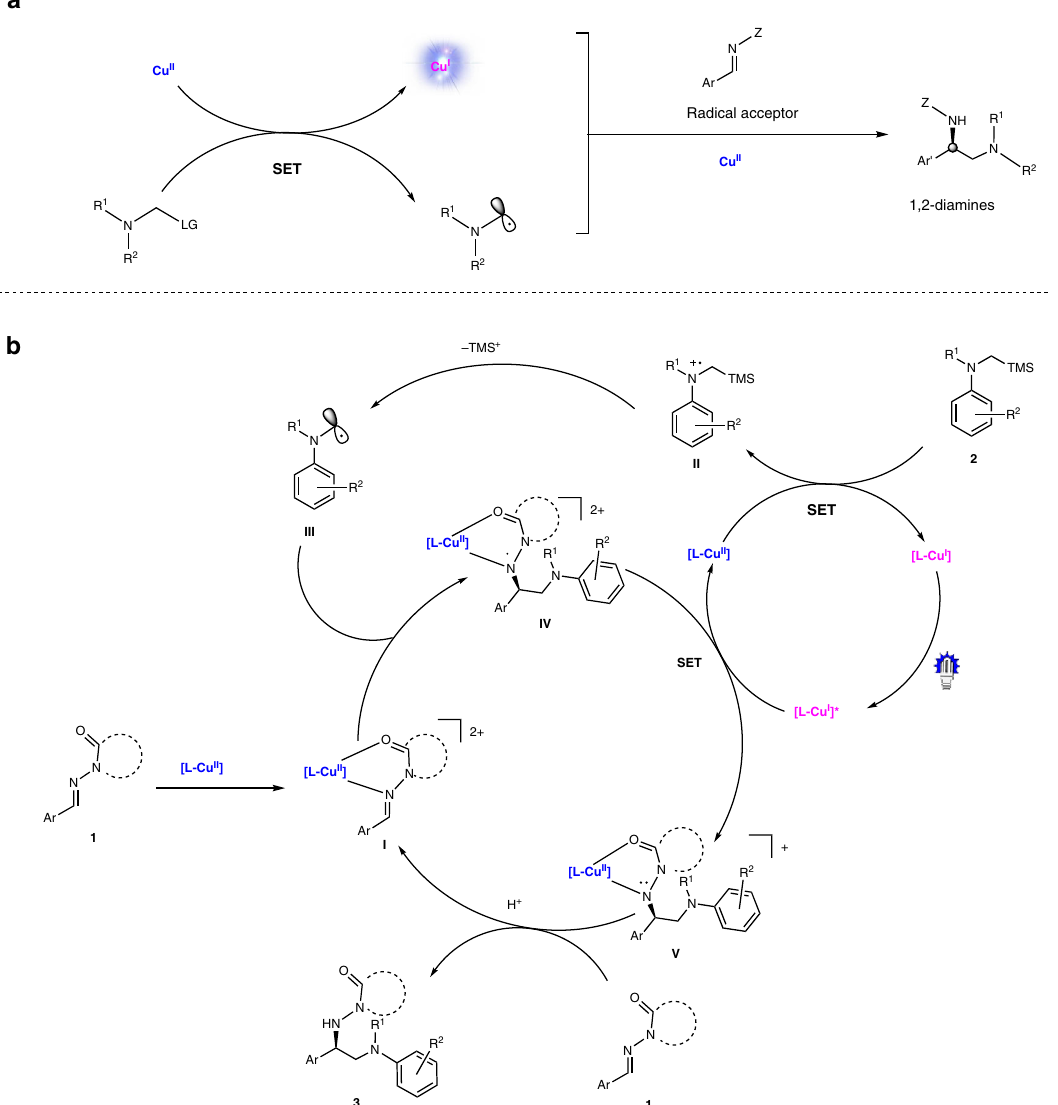
Fig. 2 Initial design and mechanistic hypothesis. a Our strategy involves single-electron oxidation of electron-rich substrates to initiate the radical process and produce a photoredox active Cu I species. b Mechanistic hypothesis, the chiral bisoxazoline copper(II) complex serves as a multifunctional